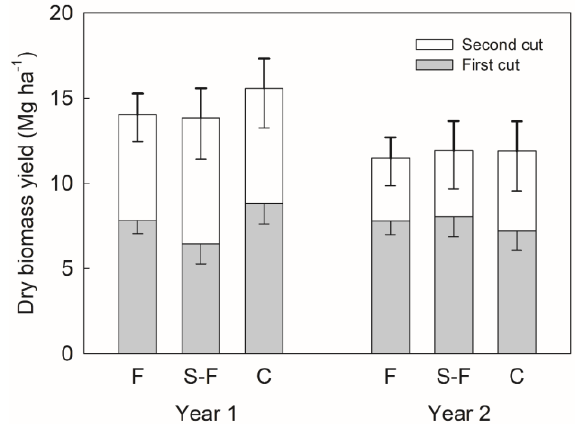
Figure 6. Mean aboveground biomass yields in the two study years from flooded (F), semi-flooded (S-F) and control (C) plots. Total bar heights denote the combined annual yield of the respective first and second cuts. Error bars represent one side of the 95 % confidence intervals ( n = 8 for F plots and n = 4 for S-F and C plots). Thin downward error bars represent errors for individual cuts and thick upward error bars represent errors for total